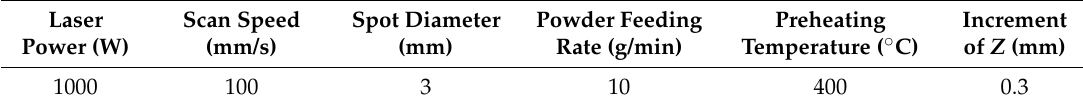
Table 1. The process parameters of laser forming